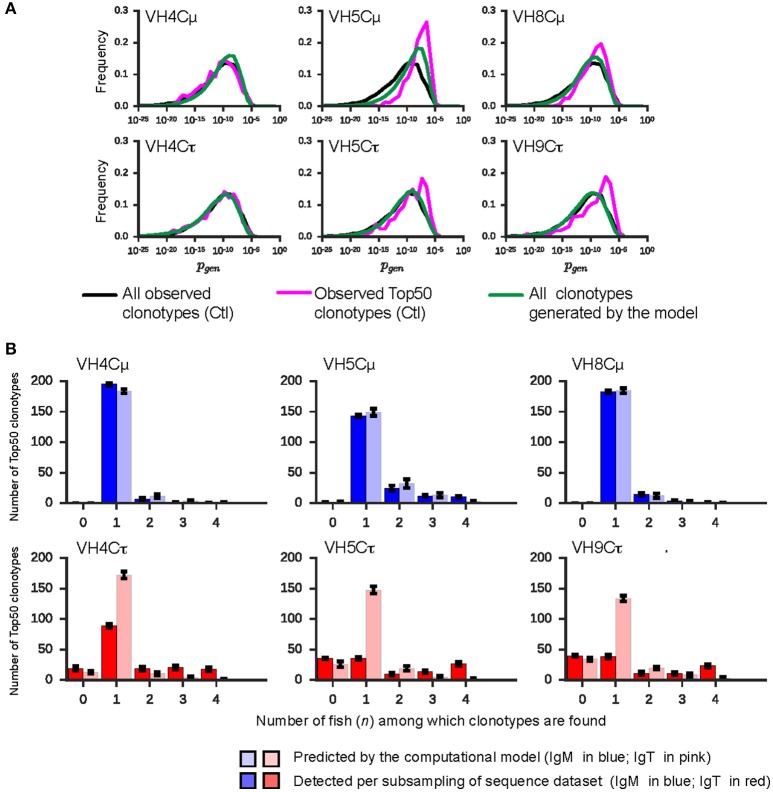
The sharing of Top50 clonotypes between individuals is determined by selection. (A) Distribution of Pgen for all clonotypes from controls (black line), for Top50 clonotypes of controls (i.e., TCLCtl; pink line), and for all sequences generated by the computational model (green line). (B) Histograms of the sharing of TCLCtl clonotypes. Left (right) bars show the numbers of measured (respectively predicted) TCLCtl clonotypes shared among n individual measured (predicted) repertoires (n = 0, 1, 2, 3, 4) out of 4. IgM is colored in blue; IgT is colored in red. Error bars for the rearrangement model correspond to standard error values across sampled repertoires. Error bars for the sequencing data correspond to the standard deviations of 10 subsamplings of 7,000.